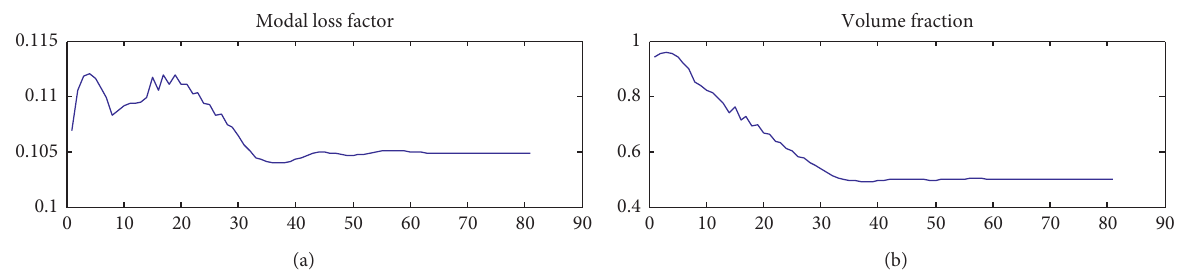
Figure 8: Convergence curves of the modal loss factor (a) and volume fraction (b) of the damping layer for the 5th modal with four holes as the initial design ( τ � 0 .